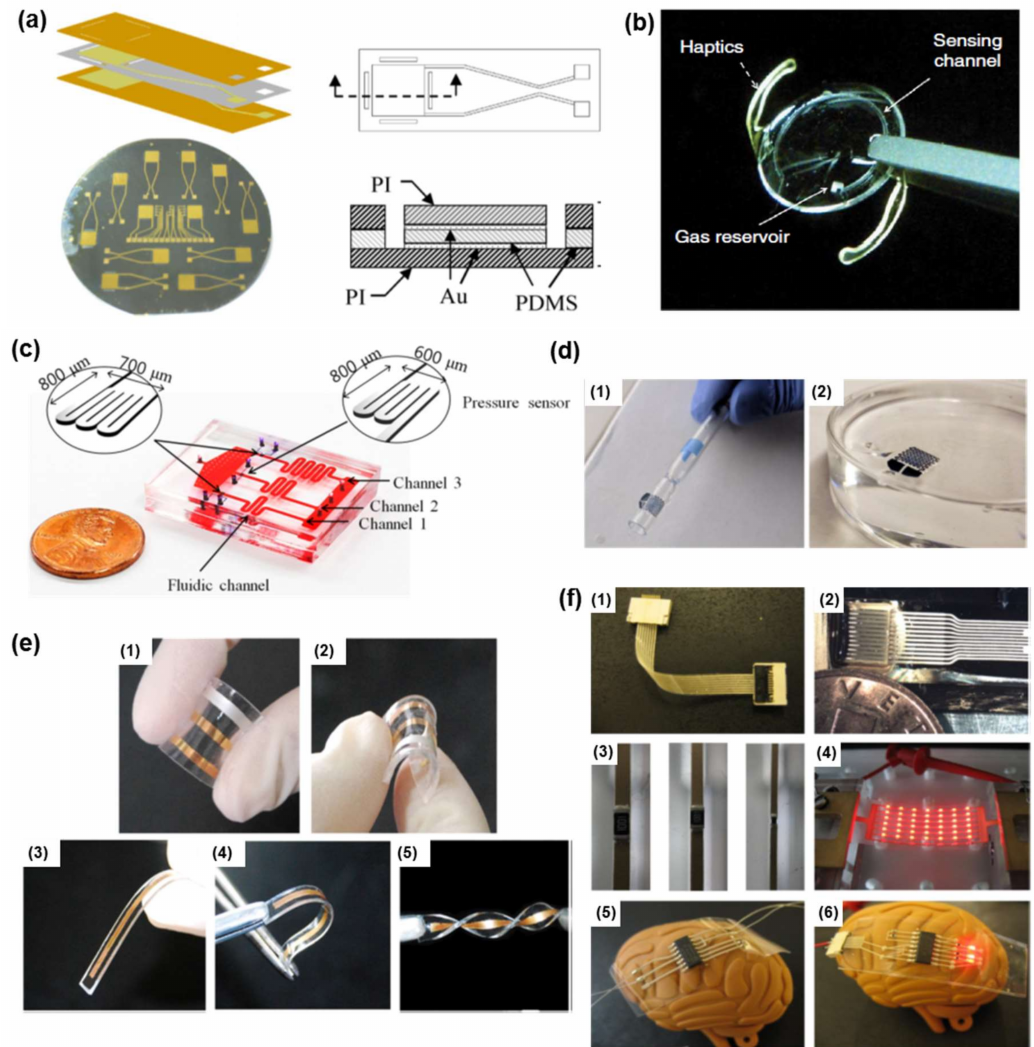
Figure 2. ( a ) Structure of the flexible capacitive pressure sensor. Reprinted with permission from Ref. [46], Copyright (2007), Elsevier; ( b ) Photograph of the microfluidic pressure sensor embedded within the intraocular lens. Reprinted with permission from Ref. [43], Copyright (2014), Springer Nature; ( c ) The intraocular pressure (IOP) sensor integrated in the microfluidic device consists of three PDMS layers: sensor, thin-film, and fluidic-channel layers. Reprinted with permission from Ref. [44], Copyright (2015), MDPI AG; ( d ) A flexible biosensor fabricated on the PDMS film showing the pattern flexibility (left, 1 ) and water stability (right, 2 ). Reprinted with permission from Ref. [86], Copyright (2018), Elsevier; ( e ) Pictures of a flexible PDMS-based three-electrode sensor; Top view 1 and side view 2 of the three-electrode sensor, straight 3 , bent 4 and twisted 5 working electrode. Reprinted with permission from Ref. [49], Copyright (2010), Elsevier; ( f ) Fabrication of soft electrical circuits on PDMS integrating commercially available electrical components. 1 Picture of a ribbon cable with eight conductors clamped on both ends by a commercial zero insertion force (ZIF) connector; 2 Picture of a custom-made miniature connector with 12 contacts; 3 Pictures of chip resistors bonded on conductive tracks (from left to right: 0805, 0603 and 0402 packages); 4 Picture of a large array of surface mounted device (SMD) light-emitting diodes (LEDs) bonded on a soft printed circuit board (PCB); 5 Picture of a 2-kHz clock generator produced on a 0.2-mm thick soft single-sided PCB that conforms to a plastic brain. 6 Picture of a 1-Hz clock generator with LEDs to display the output levels produced on a 0.7-mm thick double-sided soft PCB. Reprinted with permission from Ref. [84], Copyright (2014), Springer